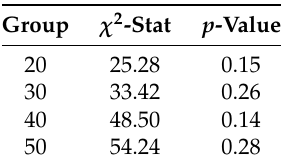
Table A9. Pearson goodness of fit test.